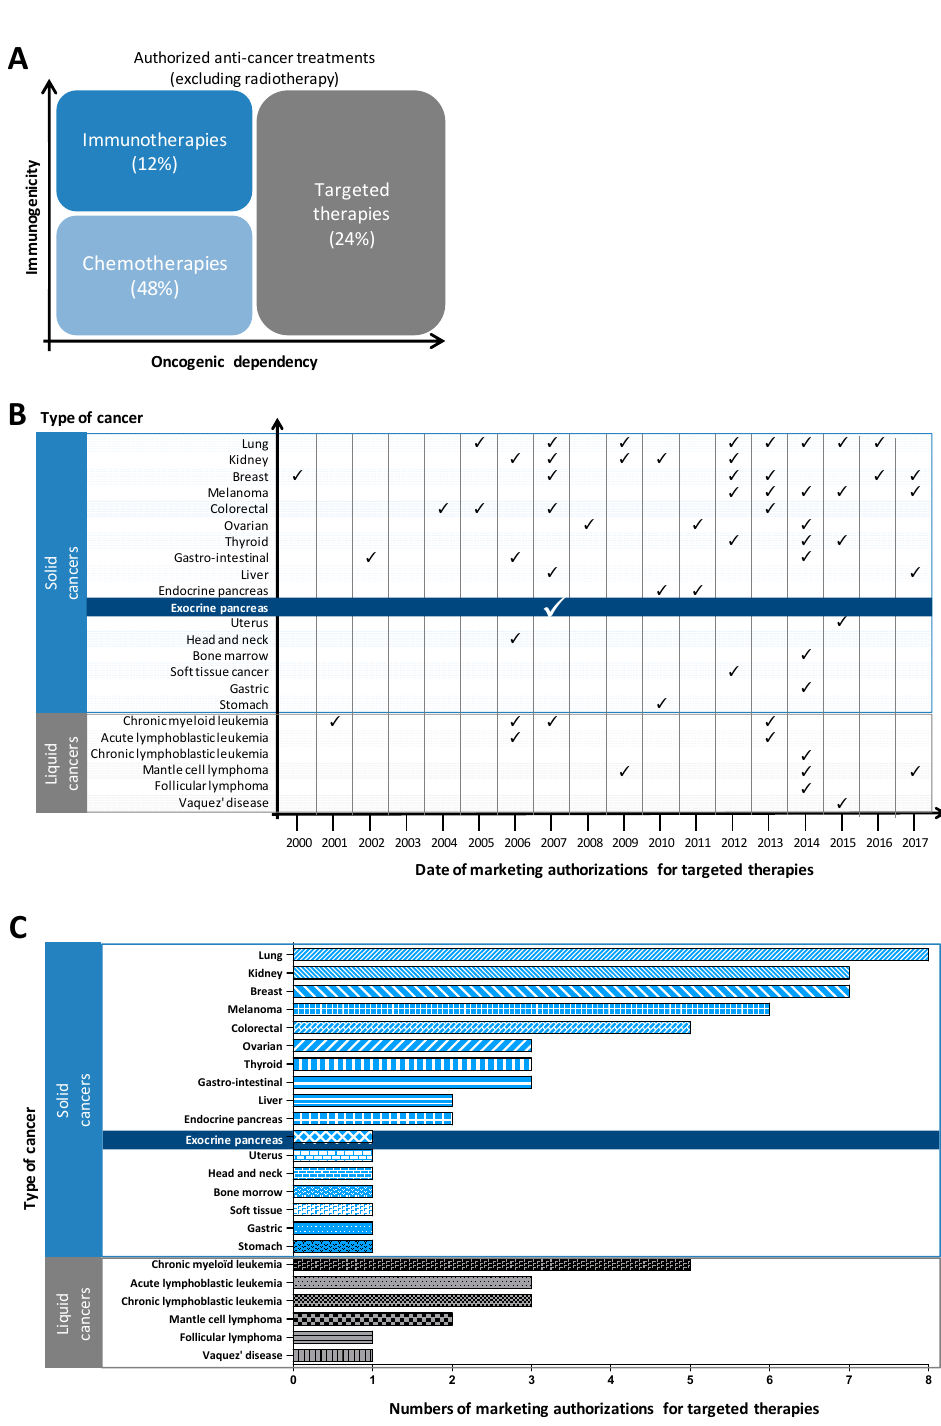
Figure 3. Evolution of the use of targeted therapies in cancers using France as an example. ( A ) Contribution in percentage of targeted therapies as compared to the therapeutic arsenal authorized for use in cancers (excluding radiotherapy). Distribution ( B ) and number ( C ) of marketing authorizations for targeted therapies. Adapted from INCa 2015 and completed with clinicaltrials.gouv. Table 2. List of the 47 anti-cancer targeted therapies authorized in France. Adapted from INCa data and completed with Vidal.fr, updated in January 2018.